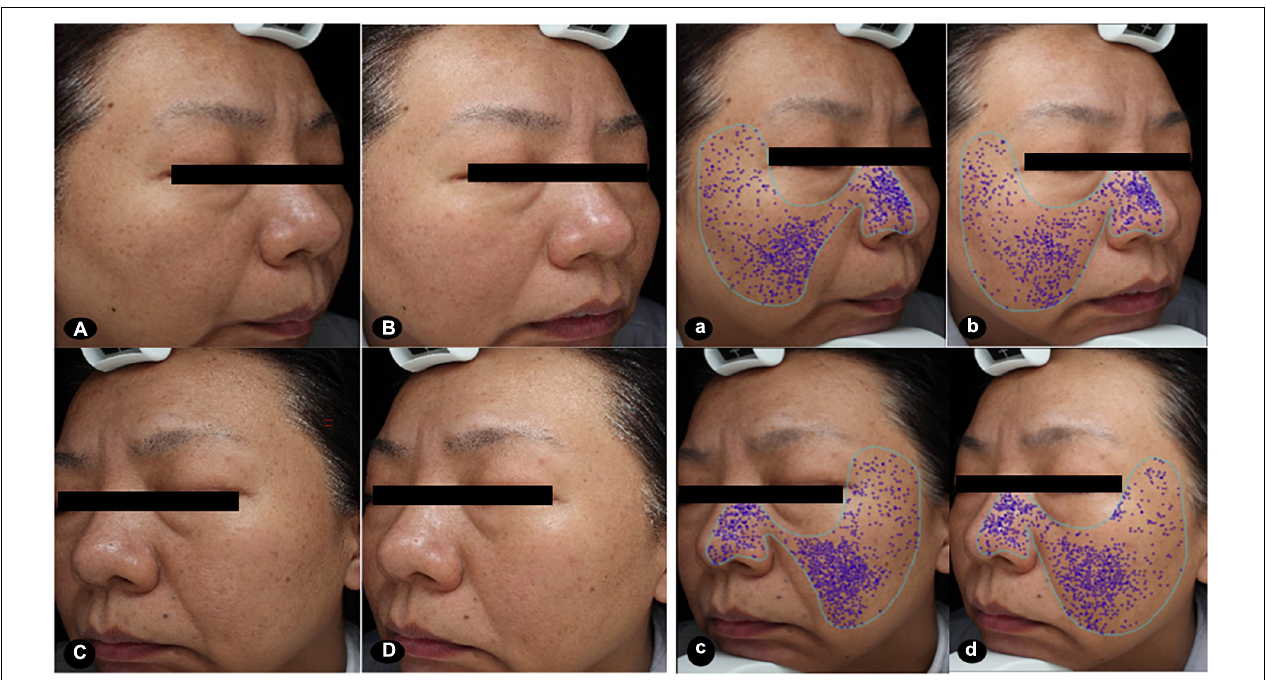
FIGURE 1 | Images at baseline and after the treatments. The clinical images presented greater improvements in brightness and size of pores after MN plus hUC-MSCs-CM [ (A,a) baseline; (B,b) after treatment], compared to MN alone [ (C,c) baseline; (D,d) after treatment]. The score of pores at the side of MN via hUC-MSCs-CM decreased from 20.29 to 13.32 after treatment. While the score of pores at another side of MN alone decreased from 22.64 to 17.71 after treatment. MN: microneedling; hUC-MSCs-CM: human umbilical cord-derived mesenchymal stem cells conditioned media.